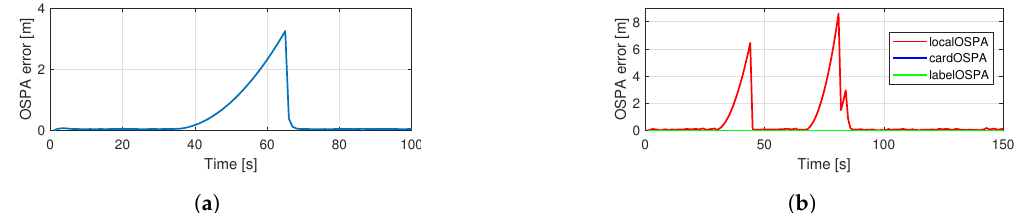
Figure 13. Performance of the proposed filter in the simulated traffic scenarios with one ( a ) and two ( b ) observed